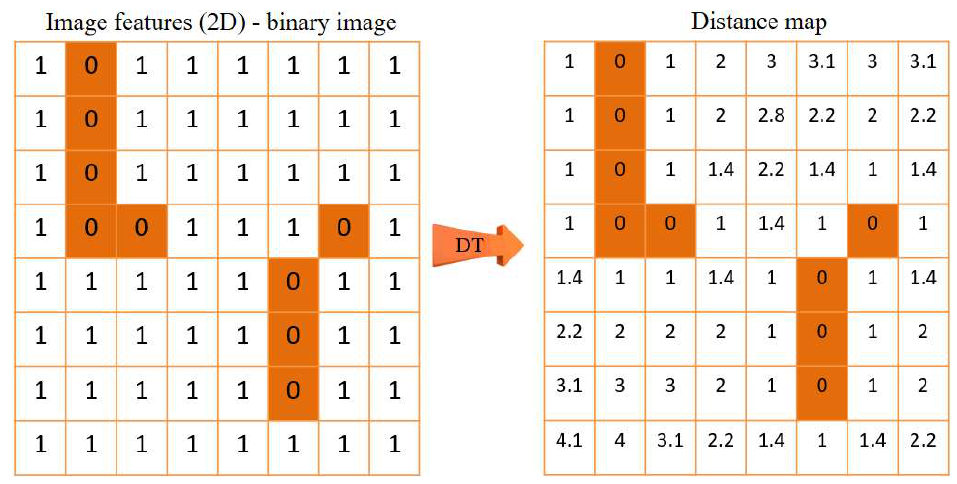
Figure 2. Distance transform (DT) method using Euclidean distance.